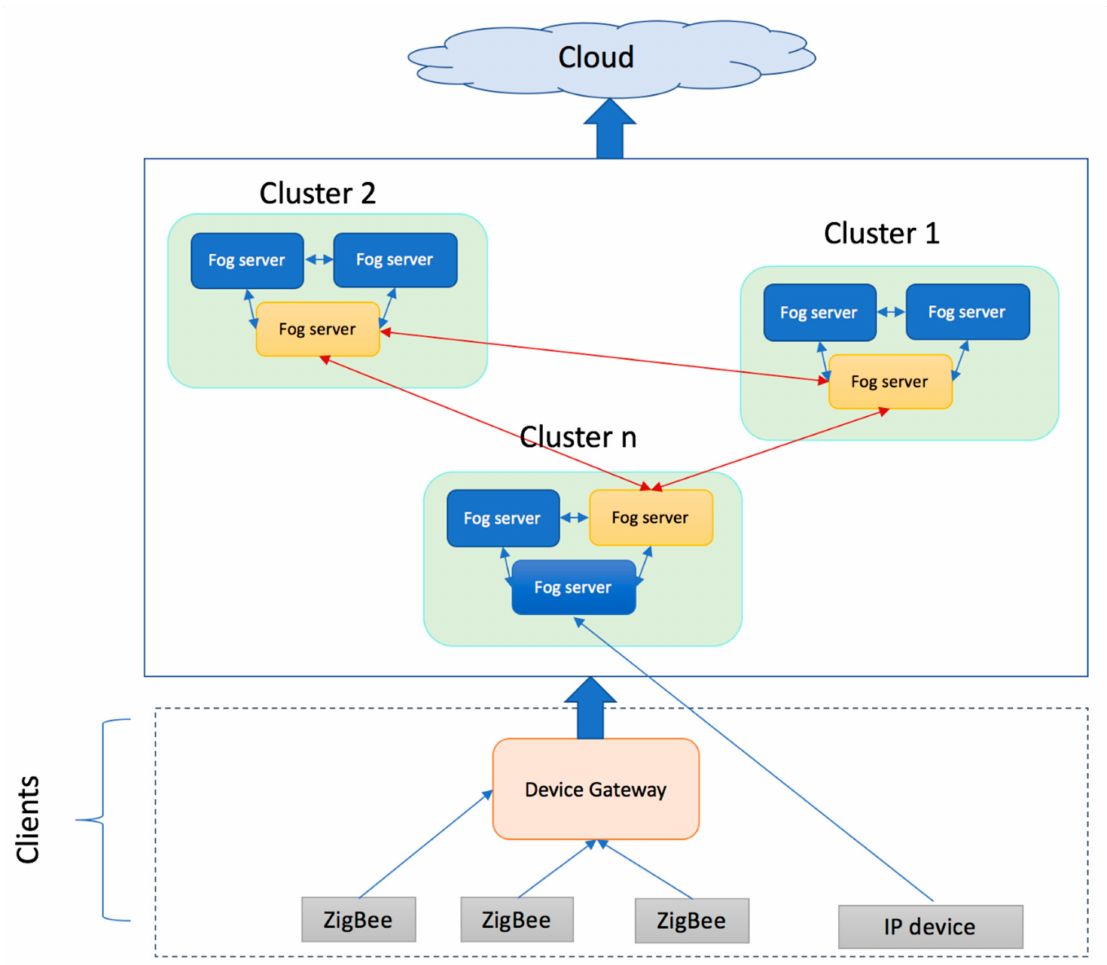
Figure 3. Eliminating the single point of failure